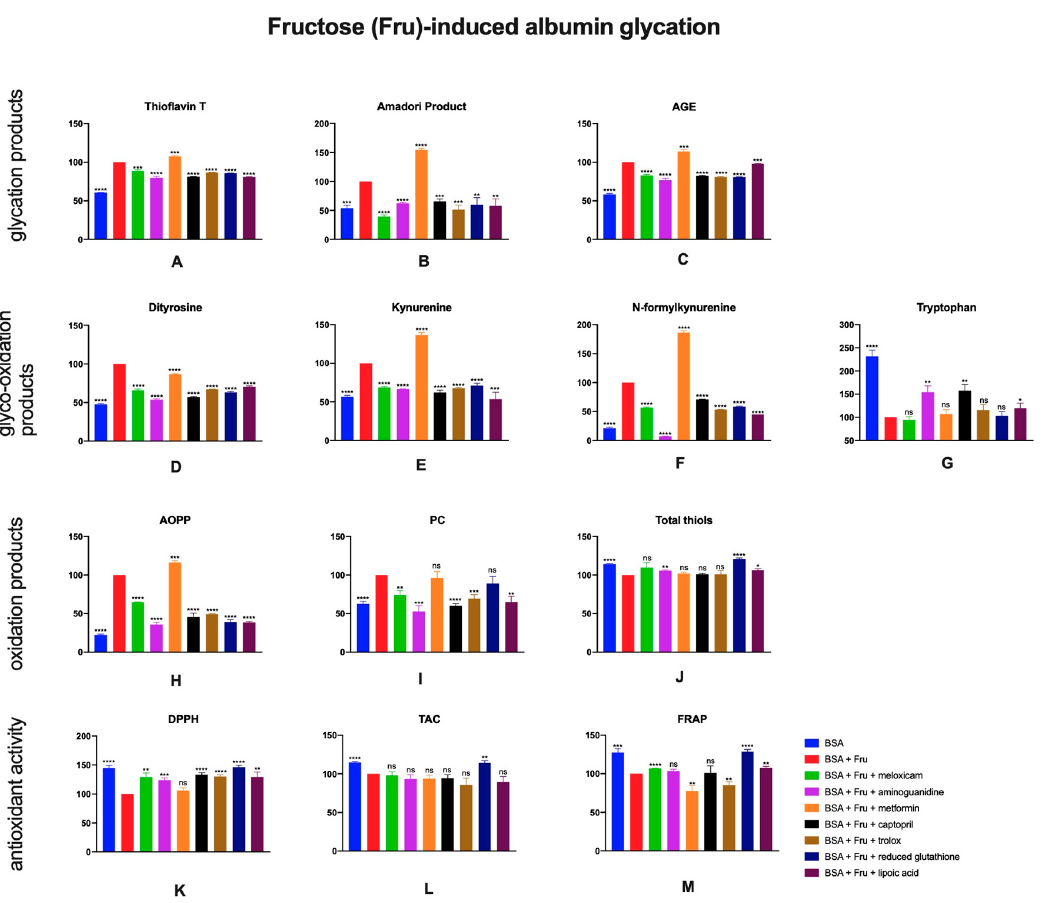
Figure 3. The effects of meloxicam, captopril, trolox, reduced glutathione, lipoic acid,